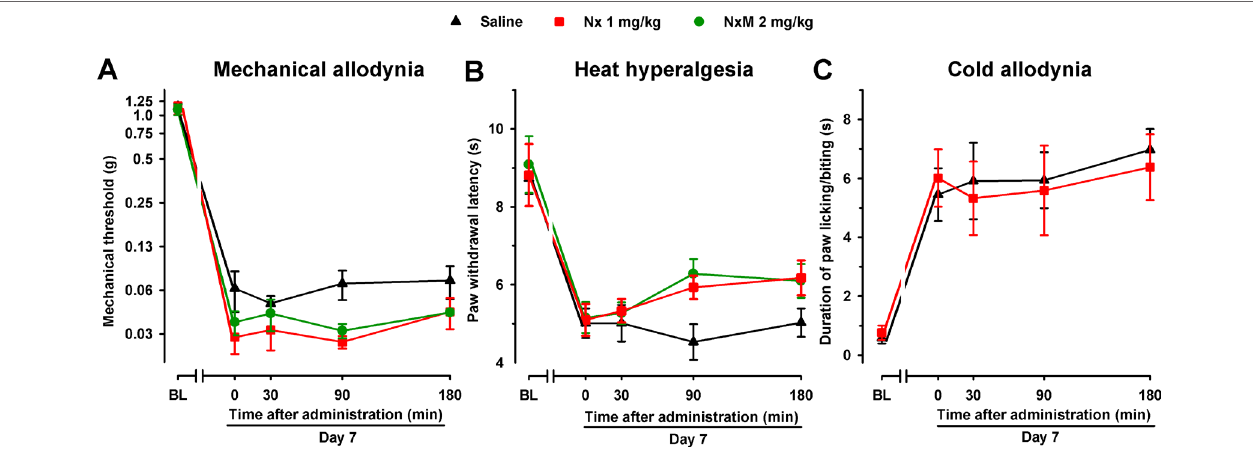
FIGURE 7 | The opioid antagonists Nx and NxM had no effect per se in female WT mice with SNI 7 days after surgery. Mechanical allodynia (A) , heat hyperalgesia (B) , and cold allodynia (C) were evaluated 1 day before (baseline, BL) and 7 days (day 7) after surgery in the paw ipsilateral to the surgery. On day 7 the responses to test stimuli were recorded immediately before (time 0) and at several times (30, 90, and 180 min) after injection of the opioid antagonist or saline. Each point and vertical line represent the mean ± SEM of the values obtained in 8–10 animals. Neither of the treatments produced statistically significant differences in comparison to the saline group (two-way repeated-measures ANOVA followed by Bonferroni test).